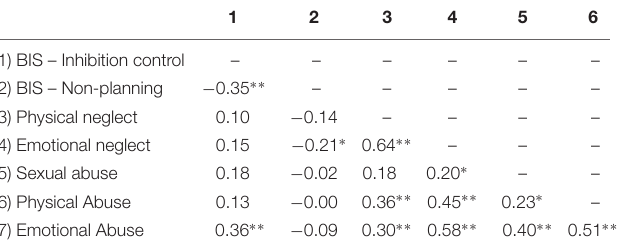
TABLE 5 | Spearman’s rho correlations between BIS-11 and CTQ patient’s subscale